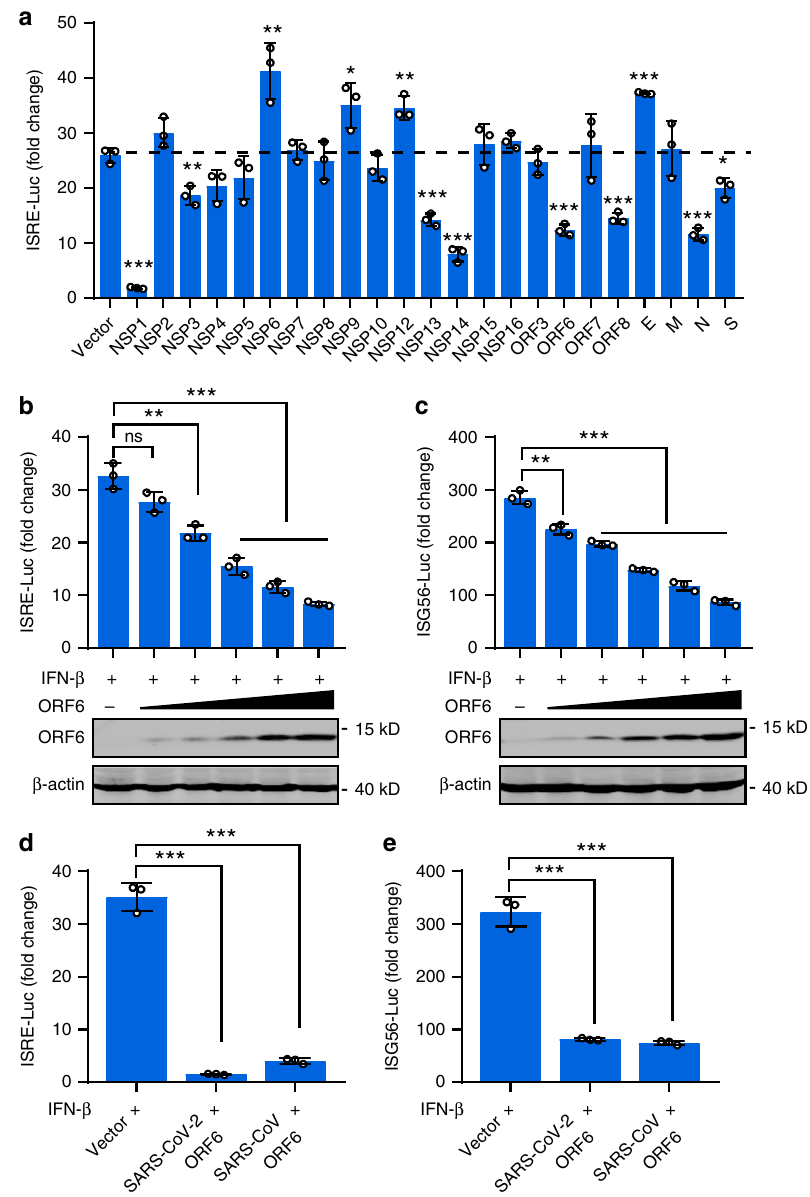
Fig. 5 ORF6 inhibits ISRE promoter activation. a The effects of SARS-CoV-2 proteins on ISRE-promoter activation. HEK293T cells were transfected with an ISRE reporter plasmid, along with a control plasmid or with plasmids expressing the indicated SARS-CoV-2 proteins. At 24 h post-transfection, cells were treated with 800 U/ml of human IFN- β for 12 h, and luciferase activity was measured. b , c The effects of SARS-CoV-2 ORF6 on ISRE and ISG56 promoter activity. HEK293T cells were transfected with am ISRE reporter plasmid ( b ) and an ISG56 reporter plasmid ( c ), along with a control plasmid or the increasing amounts of plasmids expressing SARS-CoV-2 ORF6. At 24 h post-transfection, cells were treated with 800 U/ml of human IFN- β for 12 h, and luciferase activity was measured. d , e Effect of SARS-CoV ORF6 and SARS-CoV-2 ORF6 on ISRE and ISG56 promoters. HEK293T cells were transfected with an ISRE reporter plasmid ( d ) or an ISG56 reporter plasmid ( e ), along with a control plasmid or plasmids expressing SARS-CoV ORF6 or SARS-CoV-2 ORF6. At 24 h post-transfection, cells were treated with 800 U/ml of human IFN- β for 12 h, and luciferase activity was measured. All experiments were done at least twice, and one representative is shown. Error bars indicate SD of technical triplicates. * P < 0.05, ** P < 0.01, and *** P < 0.001, two-tailed Student ’ s t -test. Source data are provided as a Source Data fi